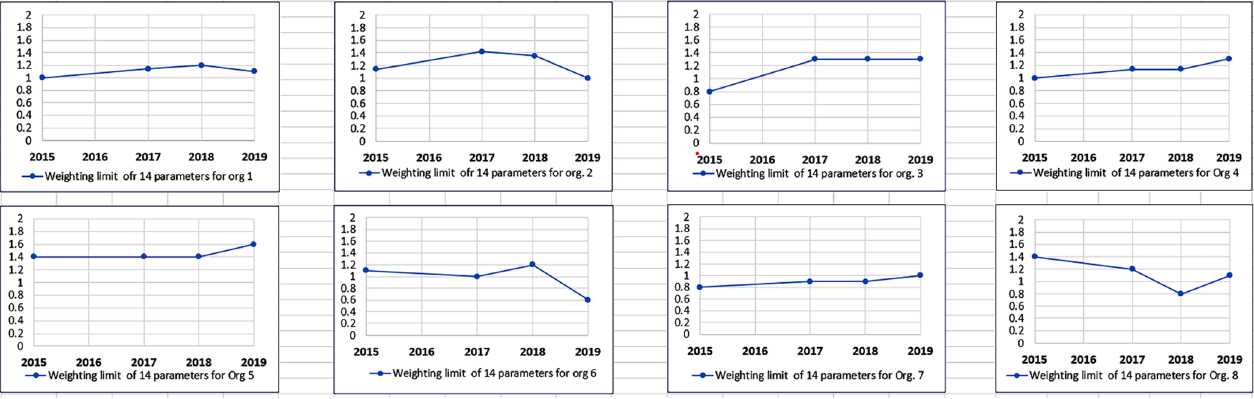
Figure 9. Development of SI results for 14 parameters for Orgs 1–8 in 2015–2017, 2018, and 2019 .